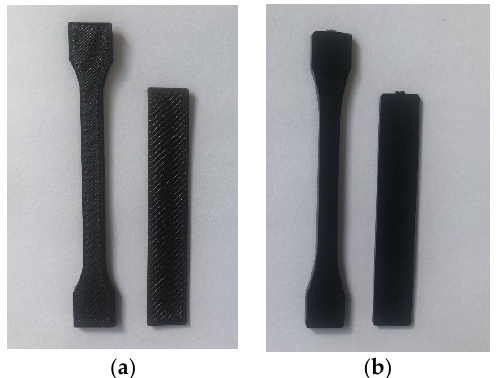
Figure 2. The dimensions of the samples— a bar and a paddle, respectively.